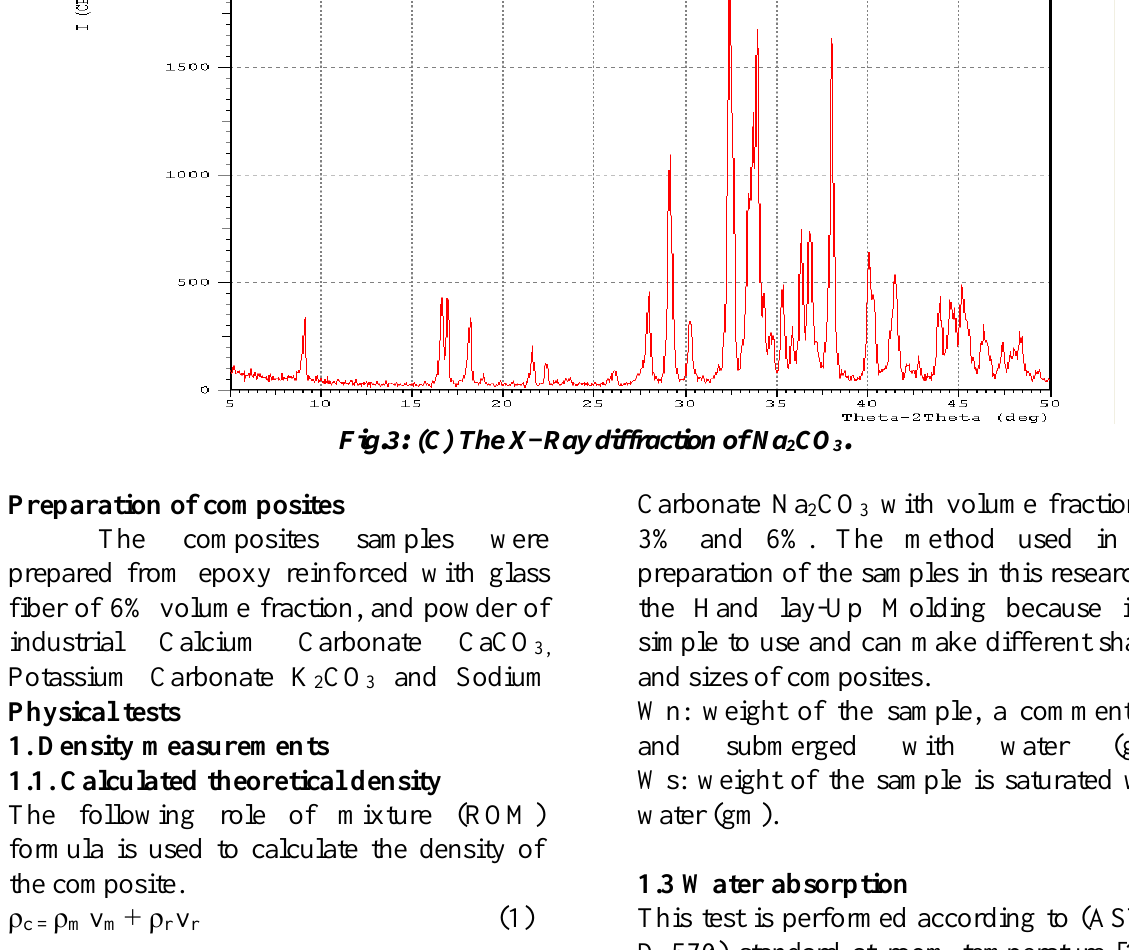
Fig.3: (C) The X- Ray diffraction of Na